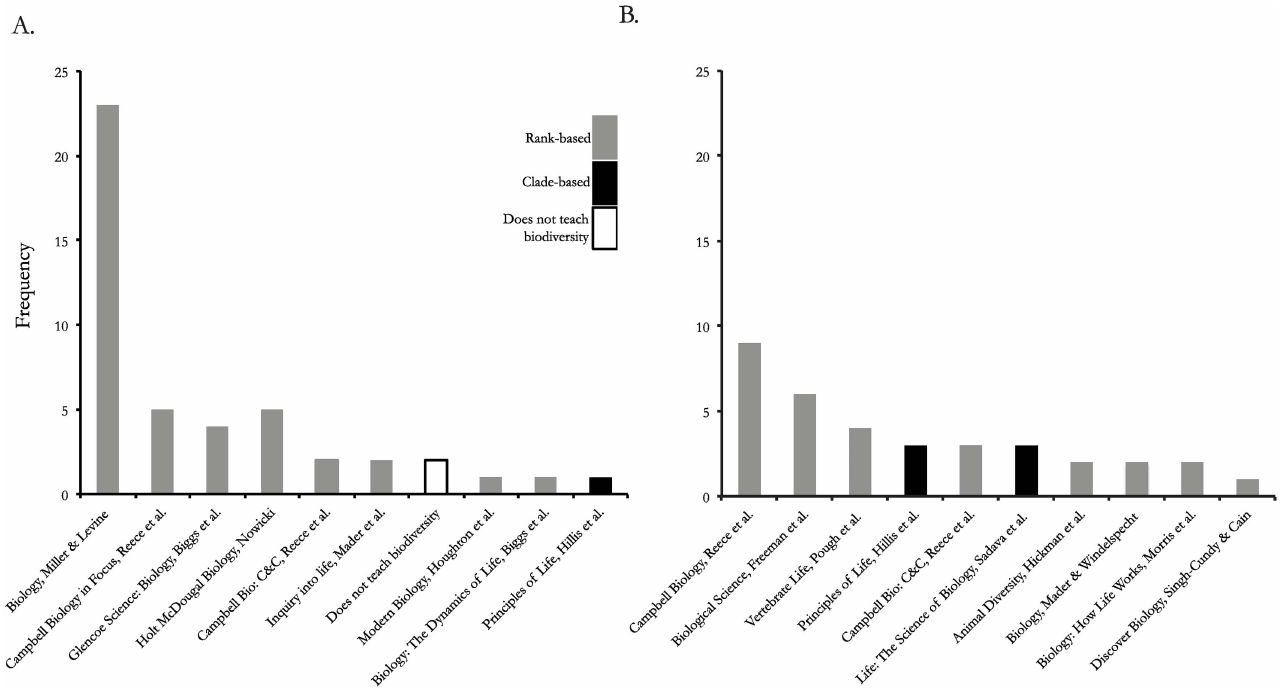
Fig 2. (A) The top ten most frequentlyused textbooks ( n = 46 textbooks) by 46 US high schools, accordingto high school teachers. At present, many Americanhigh schools continue to use aspects of the traditionalrank-basedsystem (gray bars), as opposedto a clade-basedclassification system (black bars), to assign taxon names in the tree of life. White bars reflect high school texts that do not teach biodiversity. (B) The top ten most frequentlyused textbooks ( n = 35 textbooks) by 50 large US universities to teach biodiversity.